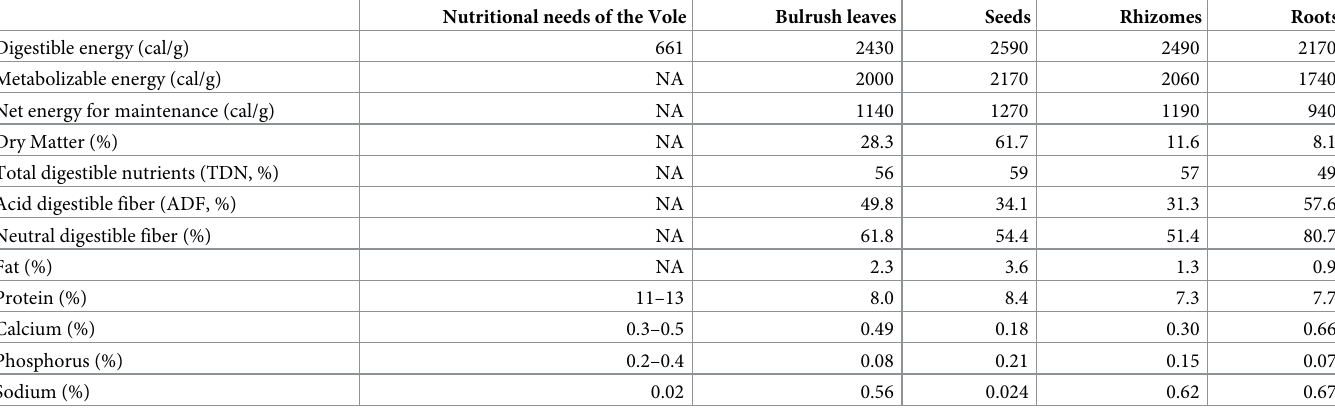
Table 2. Estimated dietary needs of Amargosa voles and nutritional content of bulrush (dry matter). Nutritional needs of the Vole